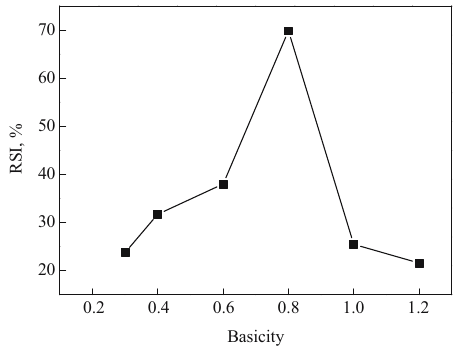
Figure 4: RSI variation of the iron ore briquettes with di ff erent basicity